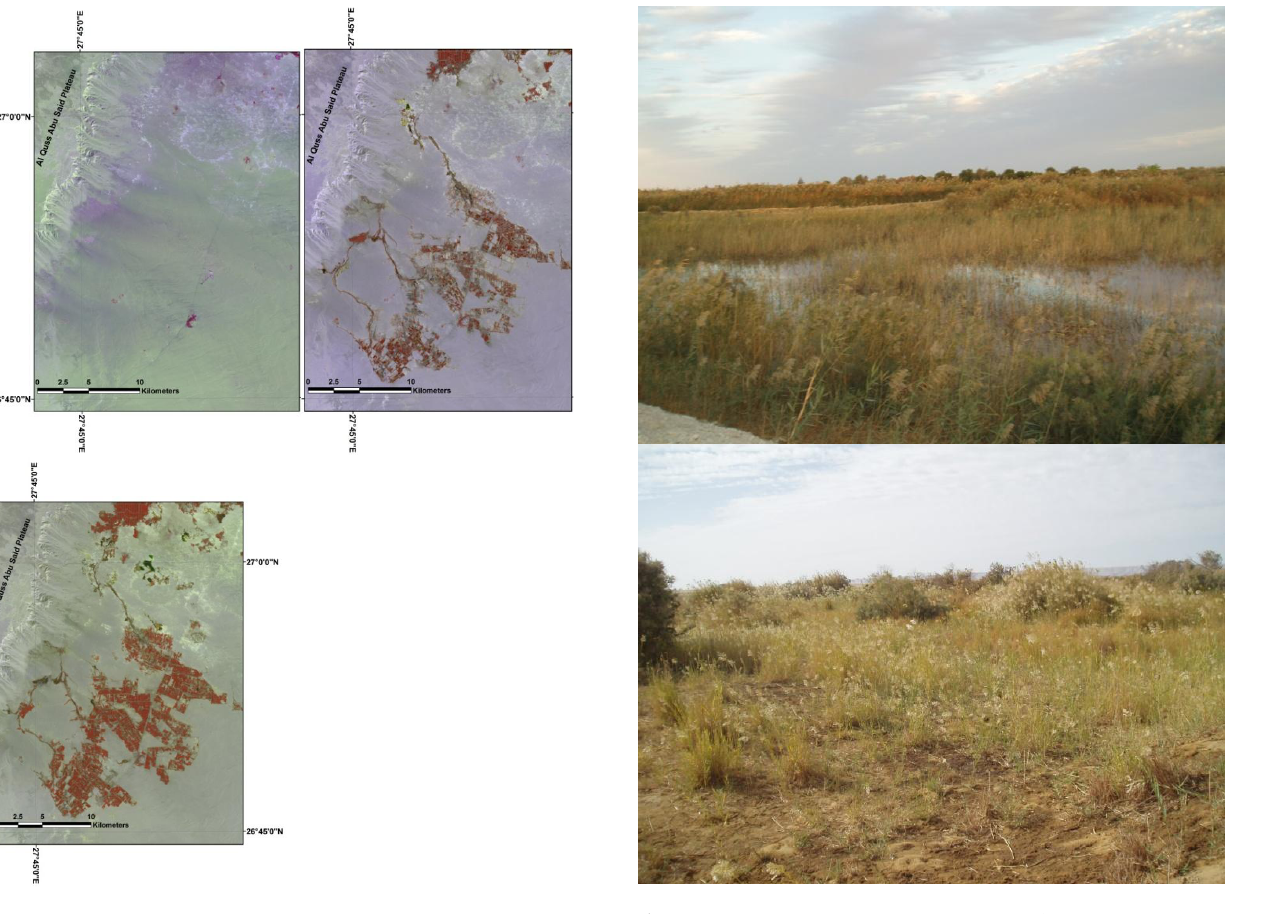
Fig. 2. The Landsat TM and ETM + images for the Farafra Oasis, which show the extent of agriculture areas (red) in 1984 (top left), Fig 2: The Landsat TM and ETM+ images for the Farafra Oasis, which show the extent of 586 2003 (top right) and 2011 (bottom). Note the development of seep- agriculture areas (red) in 1984 (left), 2003(middle) and 2011 (right). Note the development of 587 seepage channels and water ponds (black ) during the period of 2003 to 2011. 588 age channels and water ponds (black ) during the period of 2003 to 589 2011.